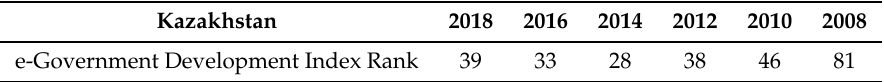
Table 1. e-Government Development Index for Kazakhstan.